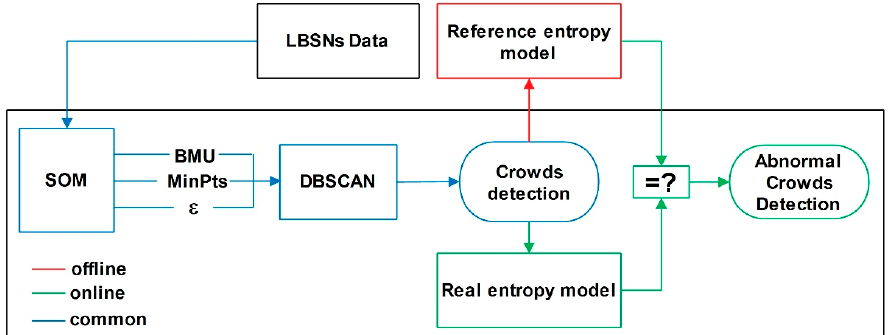
Figure 2. Urban crowd detection.